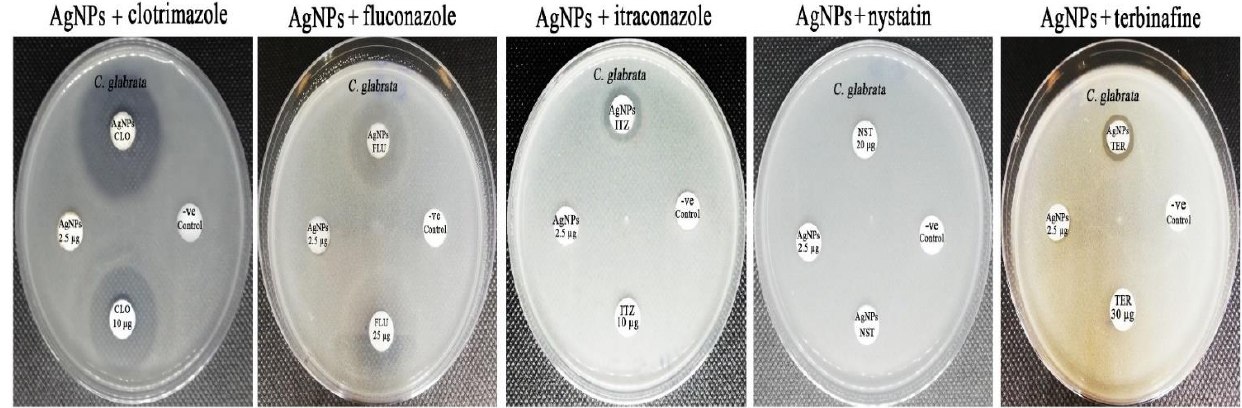
Figure 12. Synergistic patterns of biogenic AgNPs with different antifungal agents against C. glabrata strain.